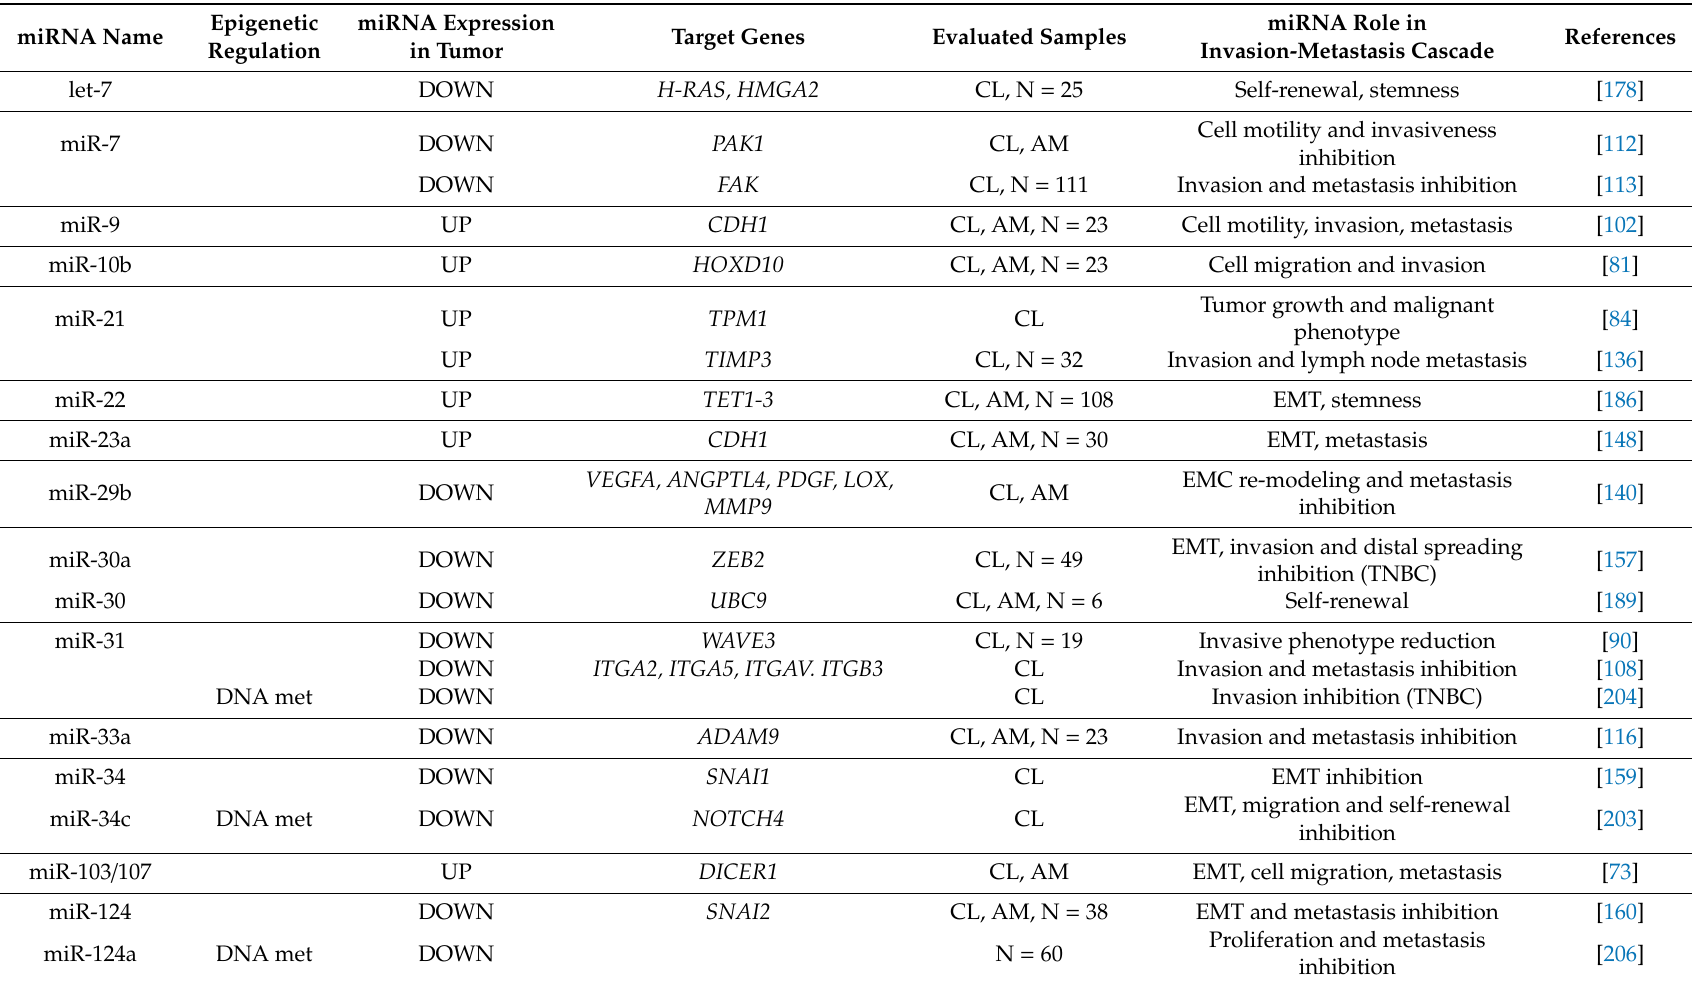
Table 1. MicroRNAs participated in invasive processes and cancer cell stemness in breast cancer cells and patient’s tumor